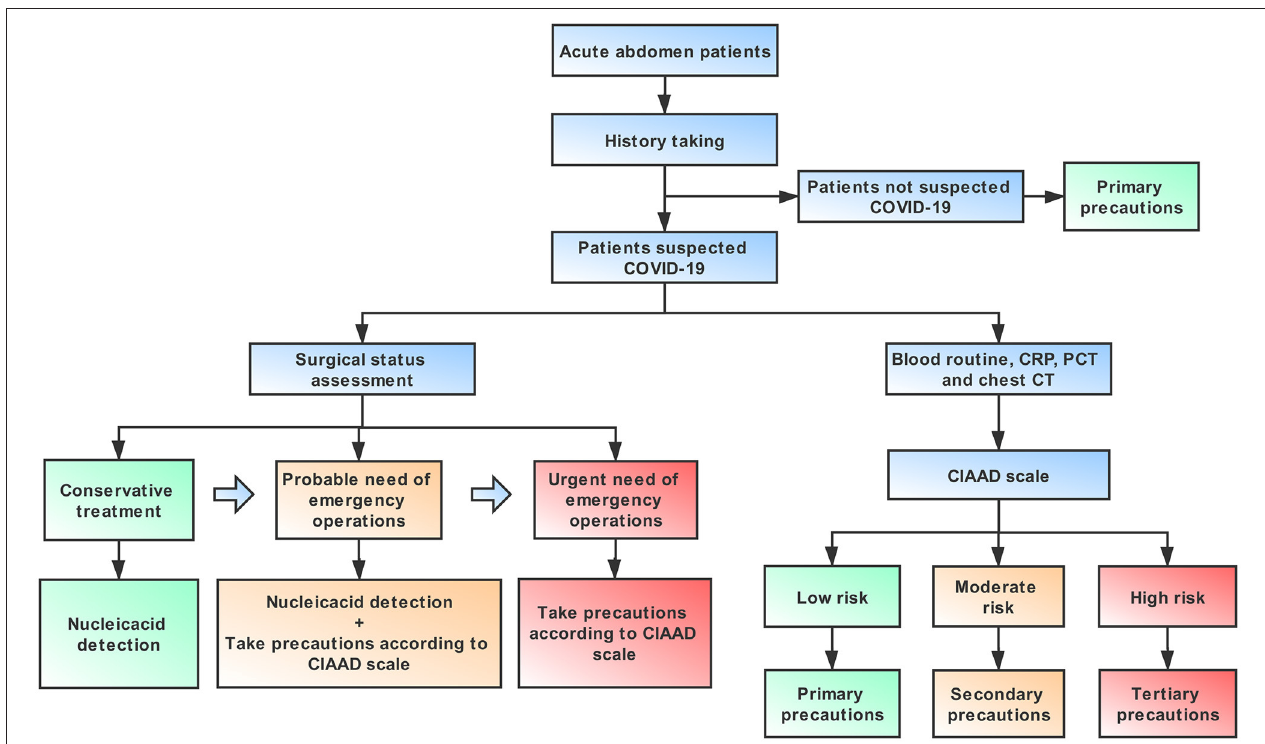
FIGURE 6 | An algorithm help surgeons to manage infectious acute abdomen patients suspected COVID-19 in the emergency department (ED). Key procedures in this algorithm are history taking, surgical status assessment, and the CIAAD scale. Primary precautions are needed for all patients in ED during the